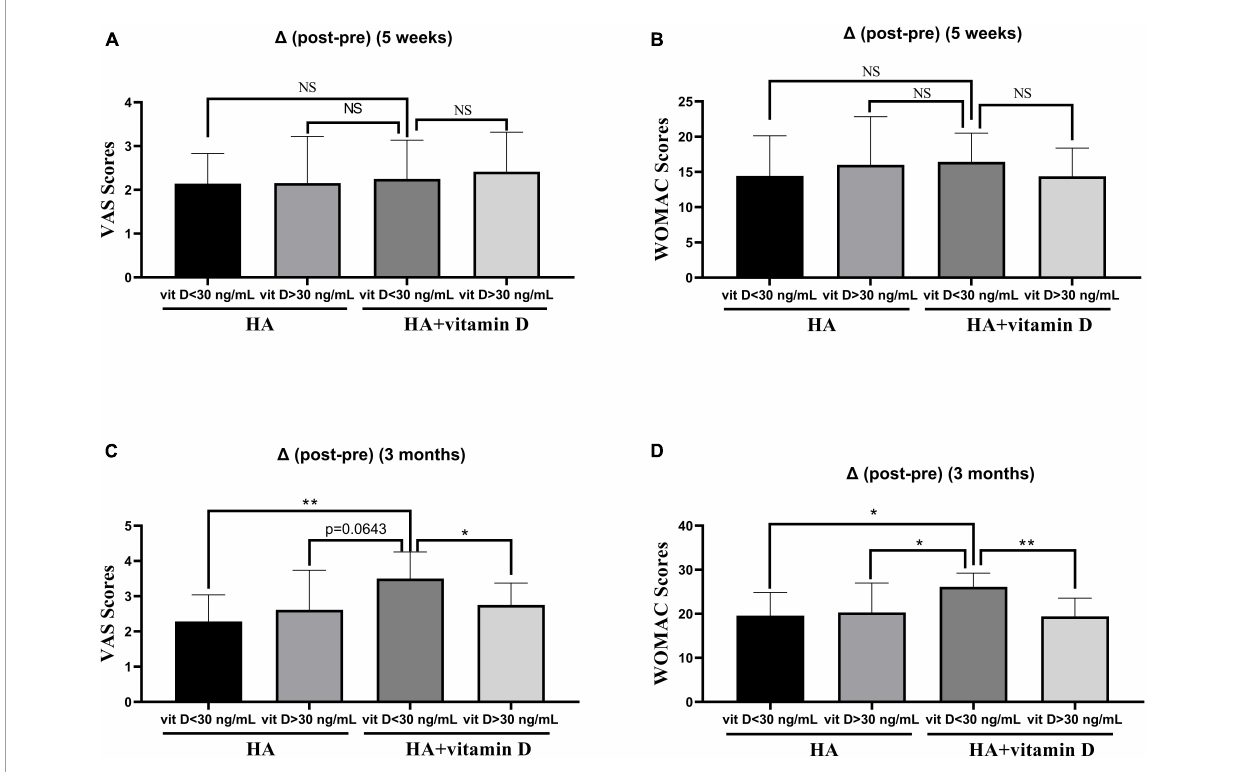
FIGURE2 Changes of the VAS and WOMAC scores in groups with different vitamin D levels. (A) Change in the VAS score after 5 weeks of treatment; (B) Change in the WOMAC score after 5 weeks of treatment; (C) Change in the VAS score after 3 months of treatment; (D) Change in the WOMAC score after 3 months of treatment. * p < 0.05, ** p < 0.01, NS represents no